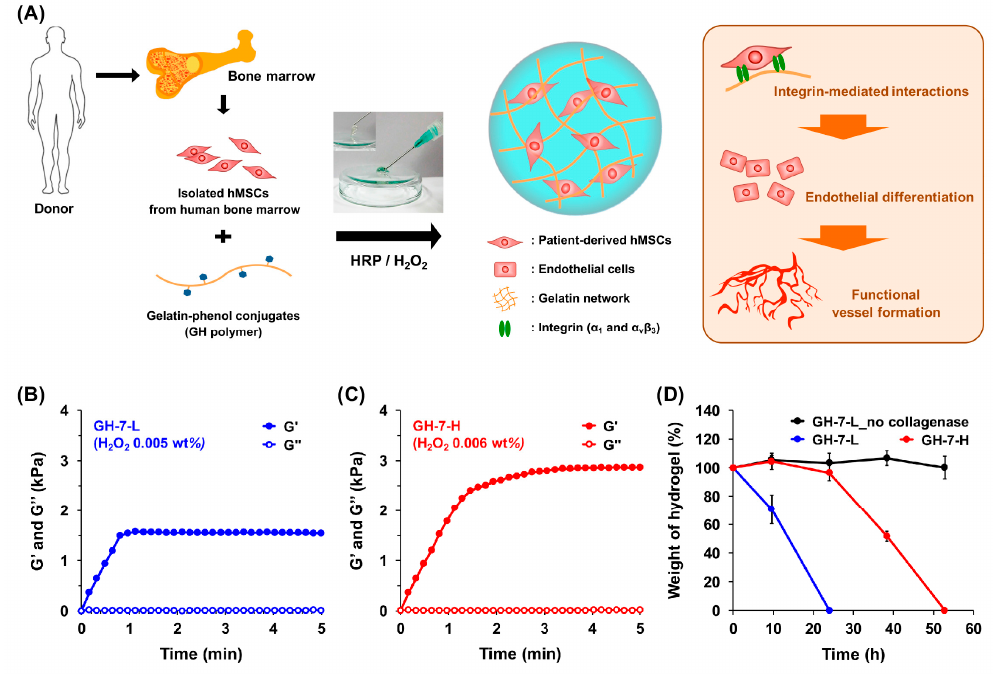
Figure 1. In situ forming gelatin − hydroxyphenyl propionic acid (GH) hydrogels as a translatable platform for mesenchymal stem cell (MSC) delivery. Schematic illustration of GH hydrogels that direct endothelial differentiation of MSCs and induce robust vascularization via integrin-mediated interactions. MSCs are collected from three patients’ bone marrow (>65 years old) and loaded in GH hydrogel matrices during HRP/H 2 O 2 cross-linking reaction ( A ); Time-sweep elastic modulus (G’) and viscous modulus (G”) of GH hydrogels with different concentration of H 2 O 2 (0.005 wt % for GH-7-L and 0.006 wt % for GH-7-H) and HRP (2.5 µg/mL) measured by rheometer ( B , C ); In vitro degradation profiles of GH-7-L and GH-7-H hydrogels in the presence or absence of collagenase (0.4 µg/mL) treatment ( n = 3) ( D ).